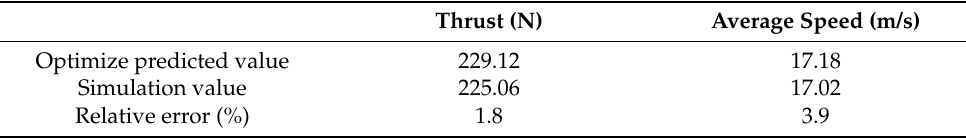
Table 6. The simulated and predicted values and their relative errors.